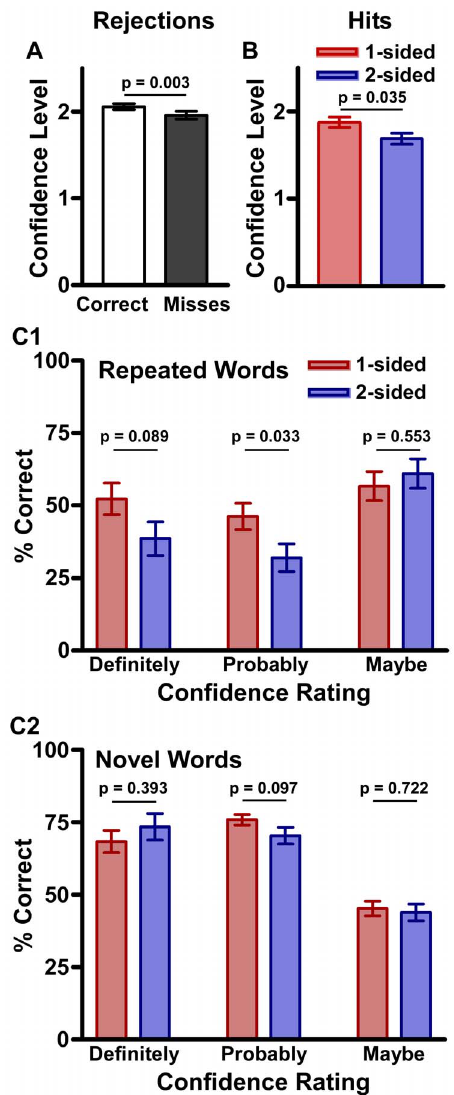
Figure 5. Recognition Test and Confidence Ratings. 5A. Confidence levels for correct rejections and misses, regardless of which conversation participants overheard. 5B. Confidence levels for hits for participants who overheard a one-sided versus two-sided conversation. 5C. The accuracy of different types of confidence ratings (definitely, probably, maybe) on the recognition test. Responses are shown for participants who overheard one-sided versus two-sided conversations. 5C1. Accuracy of responses to repeated words. 5C2. Accuracy of responses to novel words.